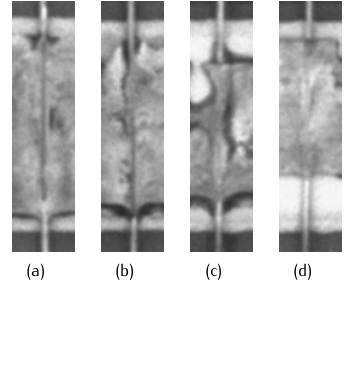
Figure 1. Example images of good ((a) and (b) and bad (c) and (d))